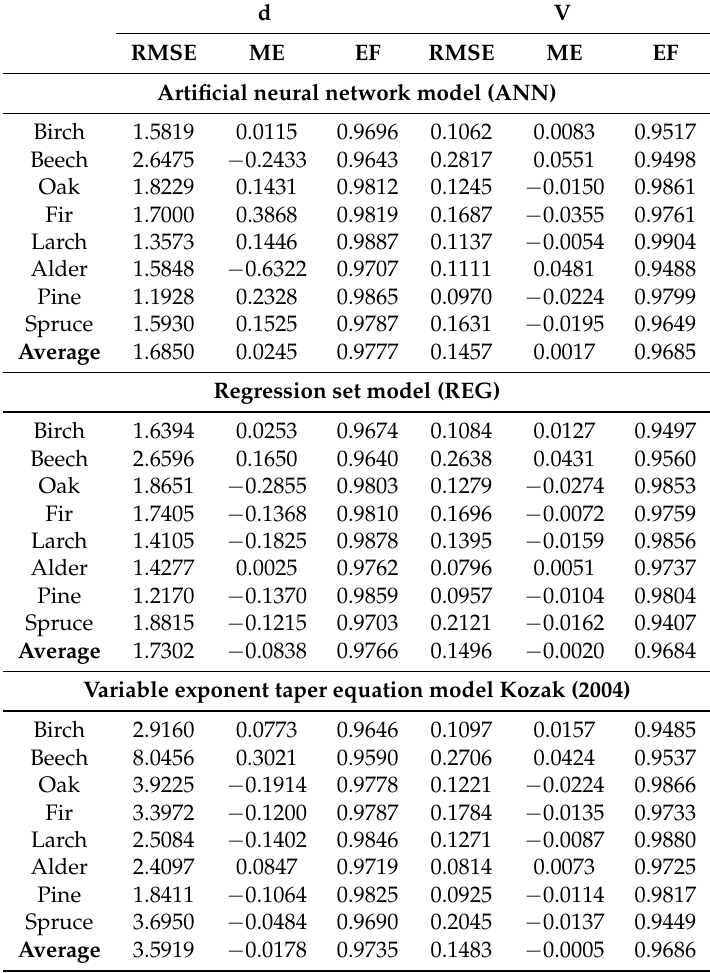
Table 3. Summary statistics of stem diameters (d) and volume (V) estimation using three methods for different tree